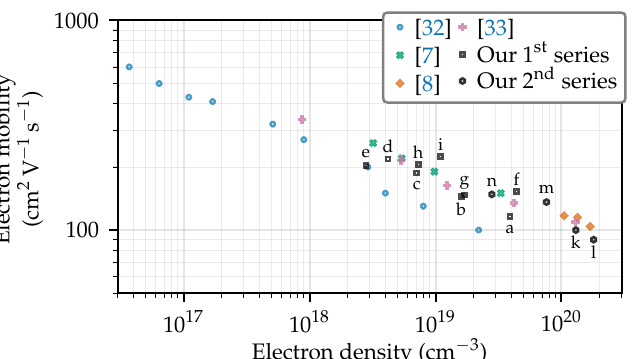
Figure 7. The electron mobility of all samples as a function of the electron density and compared to equivalent values from the literature